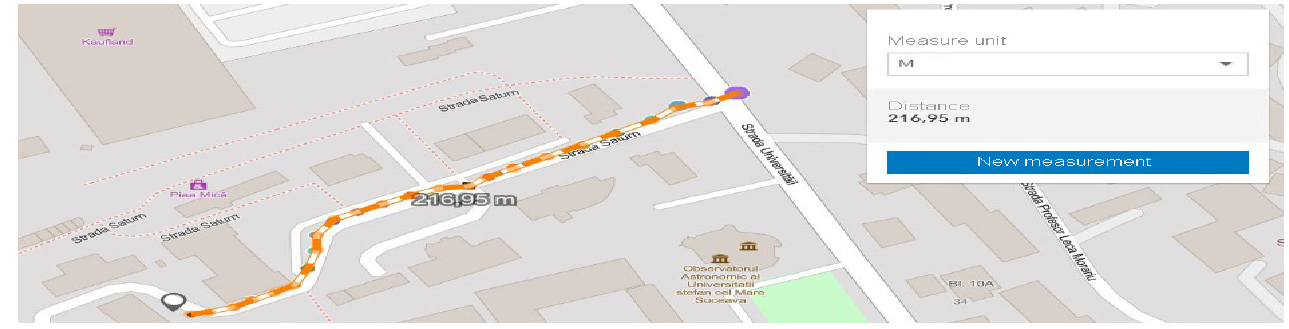
Figure 25. Route and total distance under controllable conditions.